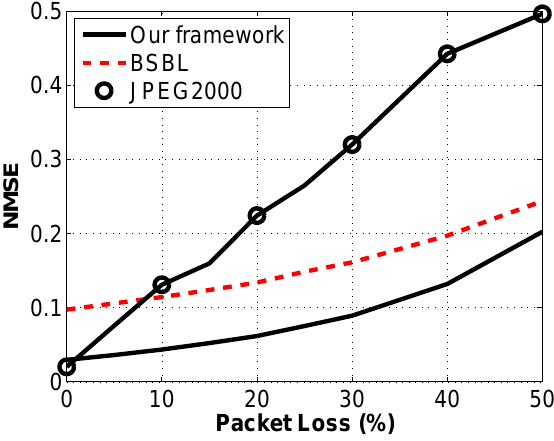
Figure 8. Reconstruction performance under packet loss for a fixed CR